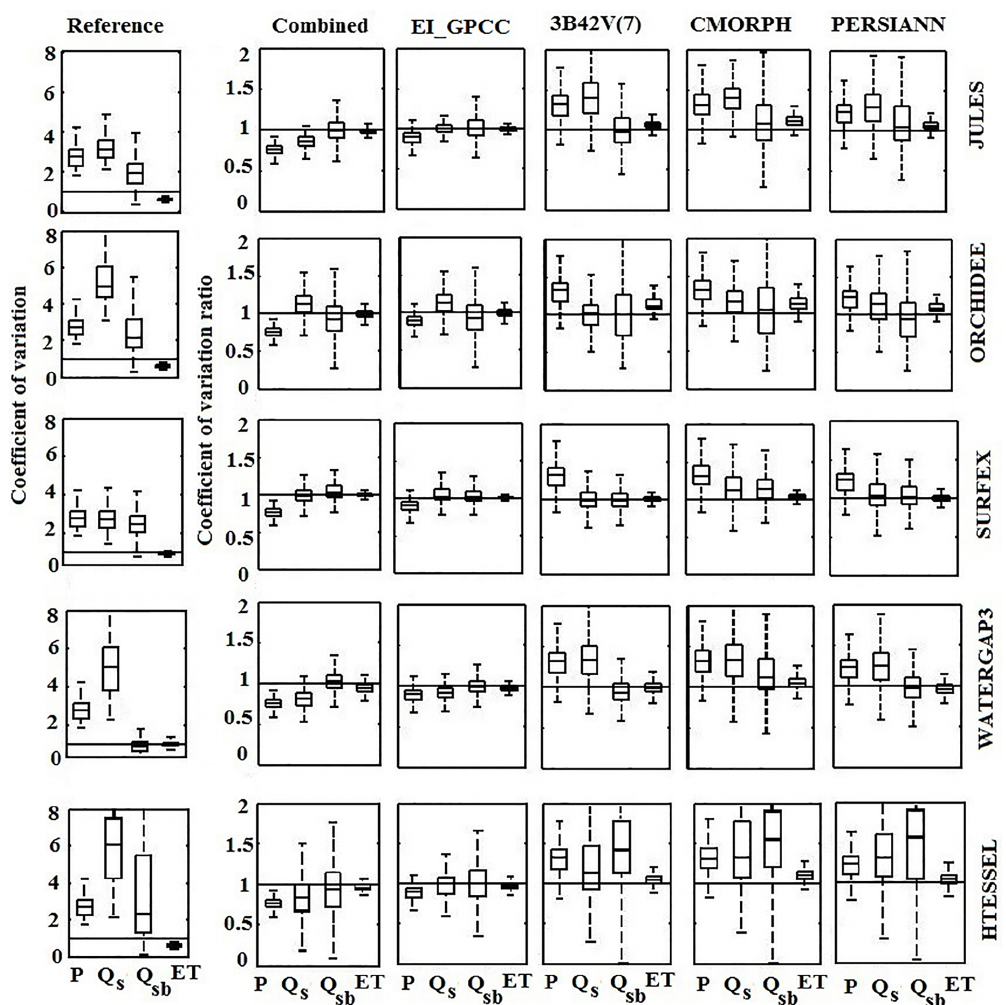
Figure 11. Relationship between coefficient of variation and coefficient of variation ratio of simulated hydrological variables and precipita-